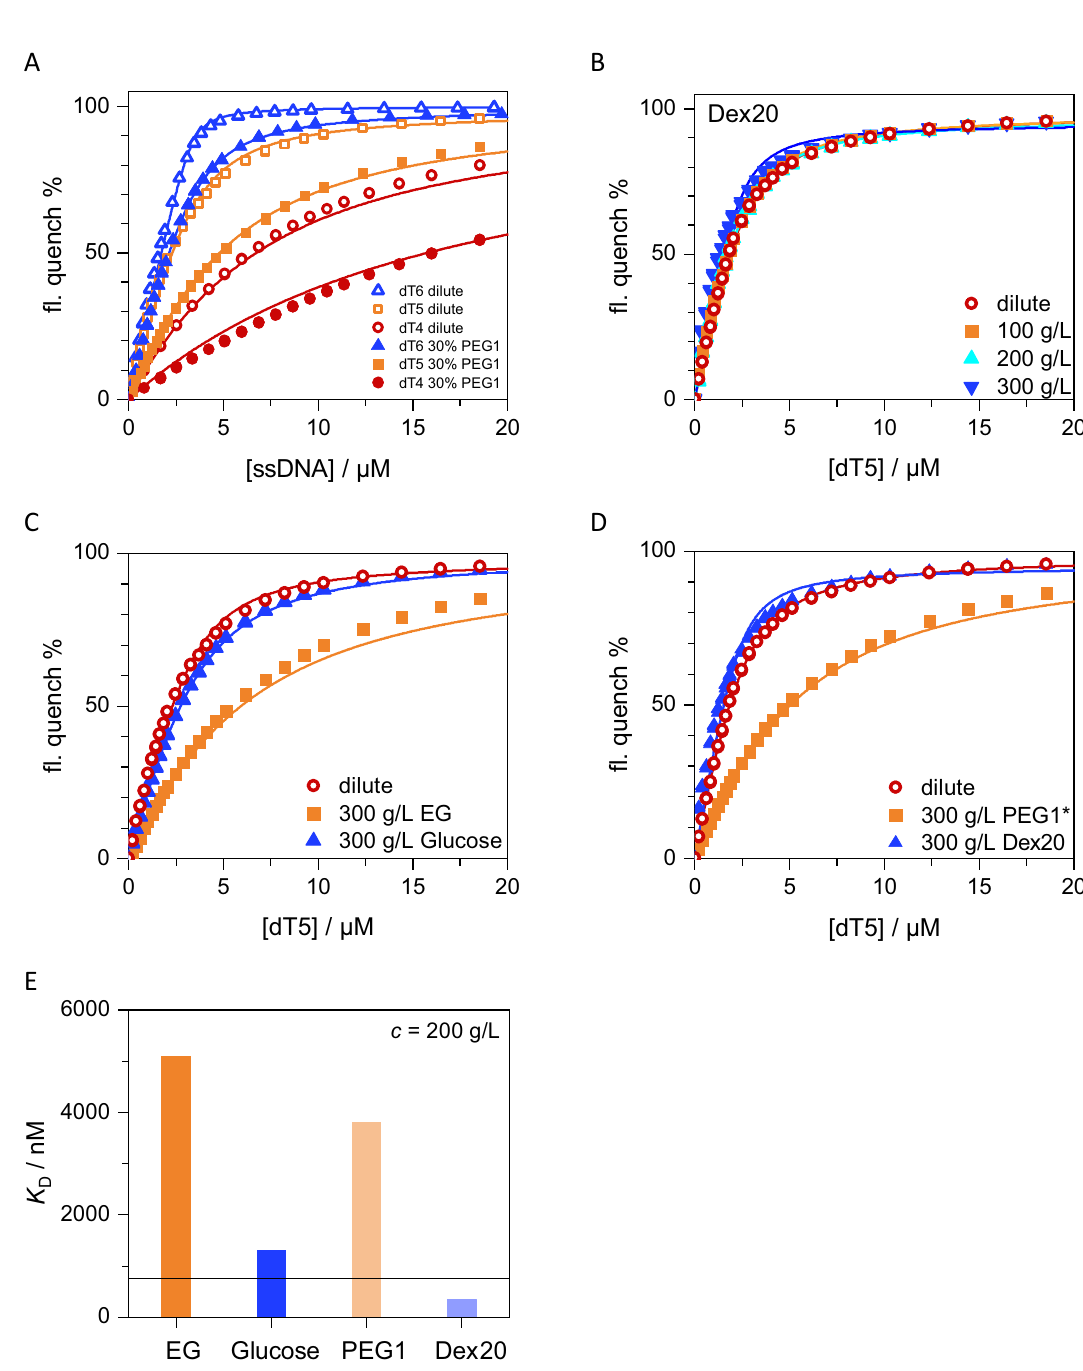
Figure 2. Probing the interaction between different oligothymidines and Bs CspB in absence and presence of a crowded environment by applying fluorescence spectroscopy in equilibrium. ( A ) The quench of intrinsic fluorescence of Bs CspB has been determined for adding dT4 (colored in red, circles), dT5 (colored in orange, rectangles), and dT6 (colored in blue, triangles) under dilute (open symbols) and 300 g/L PEG1 conditions (closed symbols). ( B ) Intrinsic fluorescence quenching has been determined for adding dT5 in absence (colored in red, circles) and presence of 100 g/L Dex20 (colored in orange, rectangles), 200 g/L Dex20 (colored in cyan, triangles with tip to top), and 300 g/L Dex20 (colored in blue, triangles with tip to bottom). ( C ) Intrinsic fluorescence quenching has been determined for adding dT5 in absence (colored in red, circles) and presence of 300 g/L EG (colored in orange, rectangles) and 300 g/L glucose (colored in blue, triangles). ( D ) Intrinsic fluorescence quenching has been determined for adding dT5 in absence (colored in red, circles) and presence of 300 g/L PEG1 (colored in orange, rectangles) and 300 g/L Dex20 (colored in blue, triangles). All experiments have been performed at T = 298 K using c Bs CspB = 4 µM, except in ( D ) where c Bs CspB = 2.8 µM was used for c PEG1 = 300 g/L. Equation (3) has been applied to perform numerical analysis of experimental data and the corresponding fitting functions are shown as continuous lines. ( E ) Binding affinity of dT5 to Bs CspB in presence of c = 200 g/L of EG, glucose, PEG1, or Dex20. The horizontal line indicates binding affinity under dilute conditions. Associated data reporting on the binding affinity between oligothymidines and Bs CspB are presented in Table 1 and Fig.